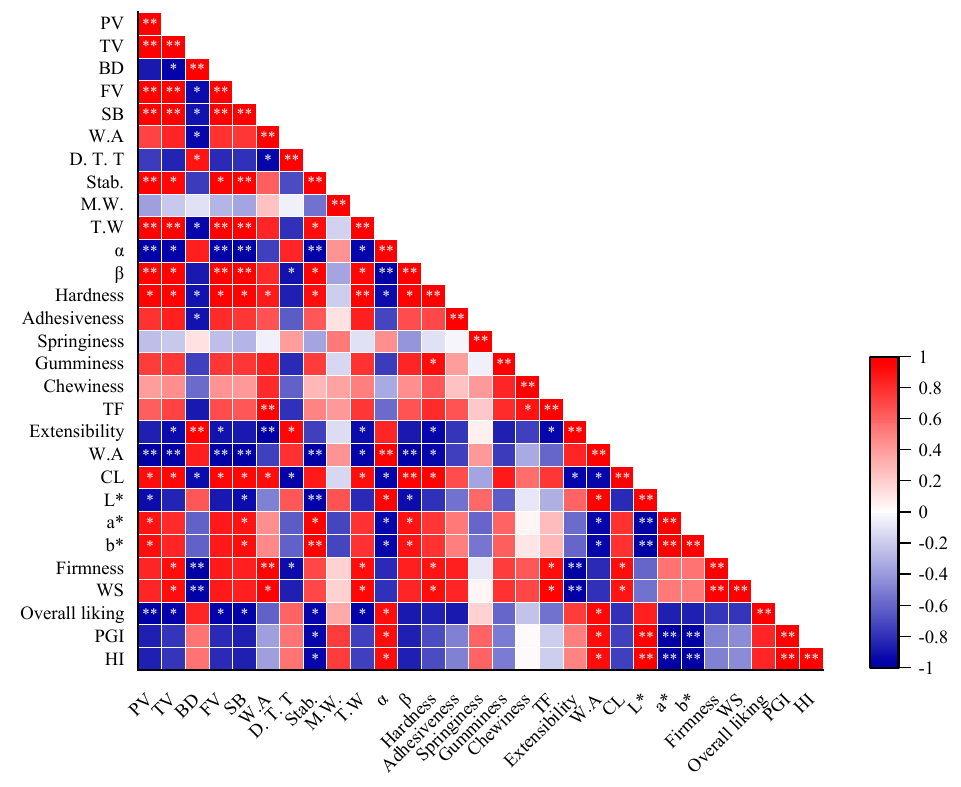
Figure 2. Correlation analysis of cooking properties and textural properties of acorn noodles and pasting properties and Mixolab characteristics of the acorn-wheat flour mixture. TF tensile force, W.A water absorption, CL cooking loss, PV peak viscosity, TV trough viscosity, BD breakdown, FV final viscosity, SB setback, D.T.T dough development time, Stab. stability, M.W mechanical weakening, T.W thermal weakening, * p < 0.05, ** p < 0.01.